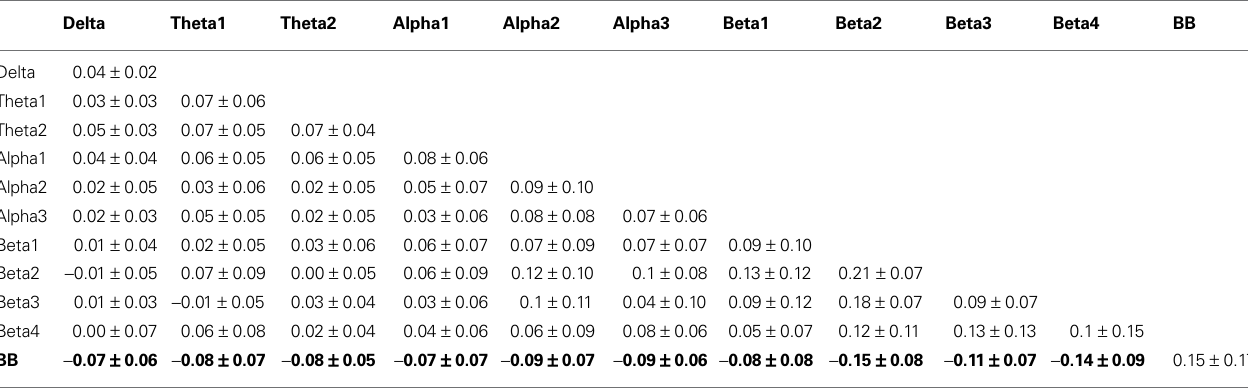
Table 1 | Mean ( ± ± half inter-quartile range) within-subject correlations between time window weights both within and across IM clusters.